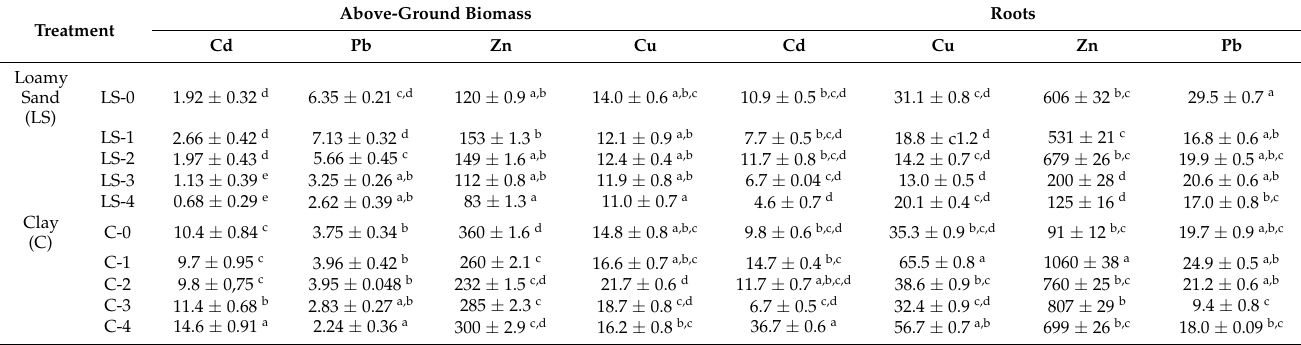
Table 7. Heavy metals content (mg kg − 1 ) in the aboveground parts and roots of S. saccharatum (L.). Above-Ground Biomass Treatment